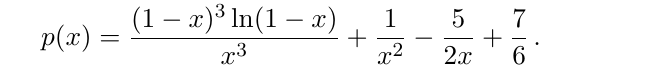
Figure 26 . Allowed regions in the parameters space of the Wilson coe(cid:14)cients C and C (cid:13)(cid:13) C (cid:13)Z (right) obtained from a global two-parameter electroweak (cid:12)t [118] with C (5) (cid:0) at 68% CL (red), 95% CL (orange) and 99% CL (yellow). We assume that contributions from dimension-6 operators not containing the ALP (cid:12)eld can be neglected at (cid:3) = 1 TeV. where (cid:14) 2 = 3, and we have (cid:0)